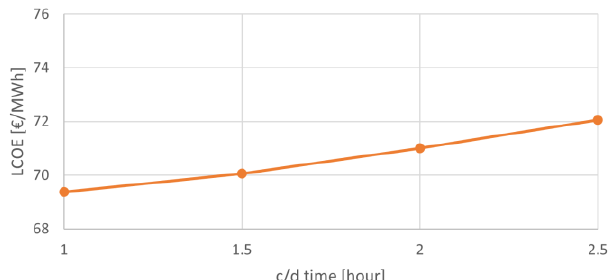
Fig. 30. LCOE versus connection/disconnection time (assembly team=3, onshore team=2 and